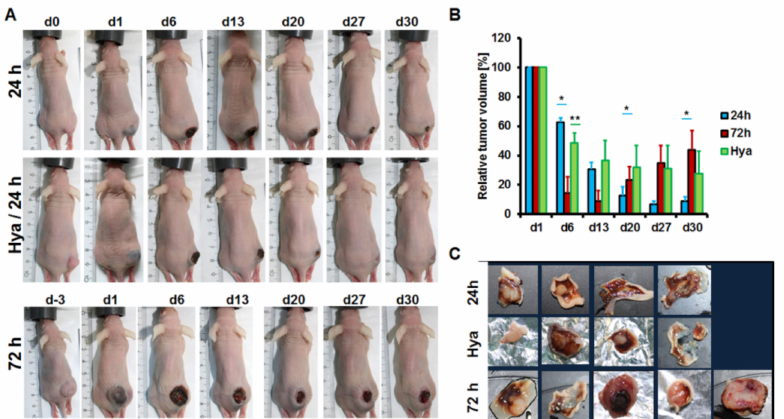
Figure 6. Representative images showing tumor growth inhibition after magnetic hyperthermia treatment alone or combined with hyaluronidase pretreatment. ( A ) Representative pictures of mice showing reduction in tumor volumes over time. ( B ) Relative tumor volumes of the different treatment groups over time. Each bar represents the mean of tumor volumes as percentage of the starting tumor volumes. n = 4/standard error of the mean (SEM) for the 24 h and Hya/24 h groups and n = 5/SEM for the 72 h group. * p < 0.05 for tumor growth differences between 24 and 72 h groups at day 6, 20, and 30. ** p < 0.04 for tumor growth differences between Hya/24 h versus 72 h group at day 6 and for Hya/24 h versus 24 h group at day 27. ( C ) Photographs of residual tumors excised on the final day (d30) of treatment monitoring substantiate the size of remaining tumor volumes determined by caliper